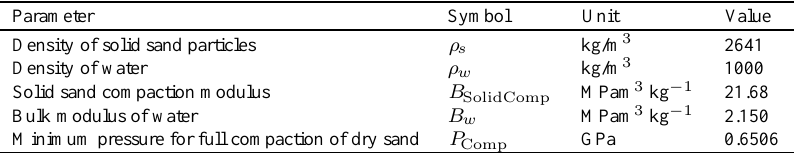
Table 1 Parameters appearing in the definition of simplified modified material model for dry,